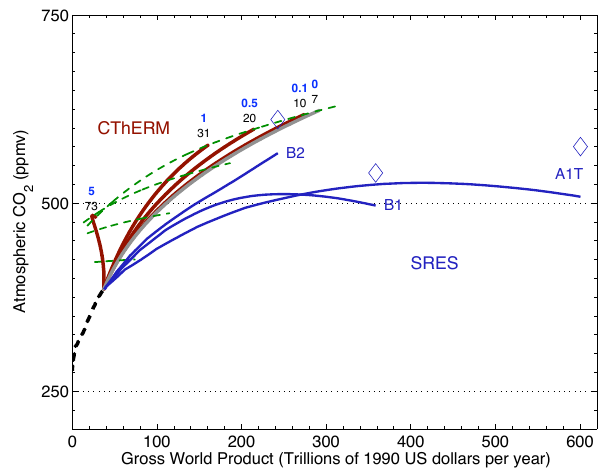
Fig. 7. As for Fig. 6 except that it is assumed that the value of carbonization c has an assumed halving time of 50 years. For comparison, the IPCC SRES trajectories that are considered are the A1T, B1 and B2 scenarios.